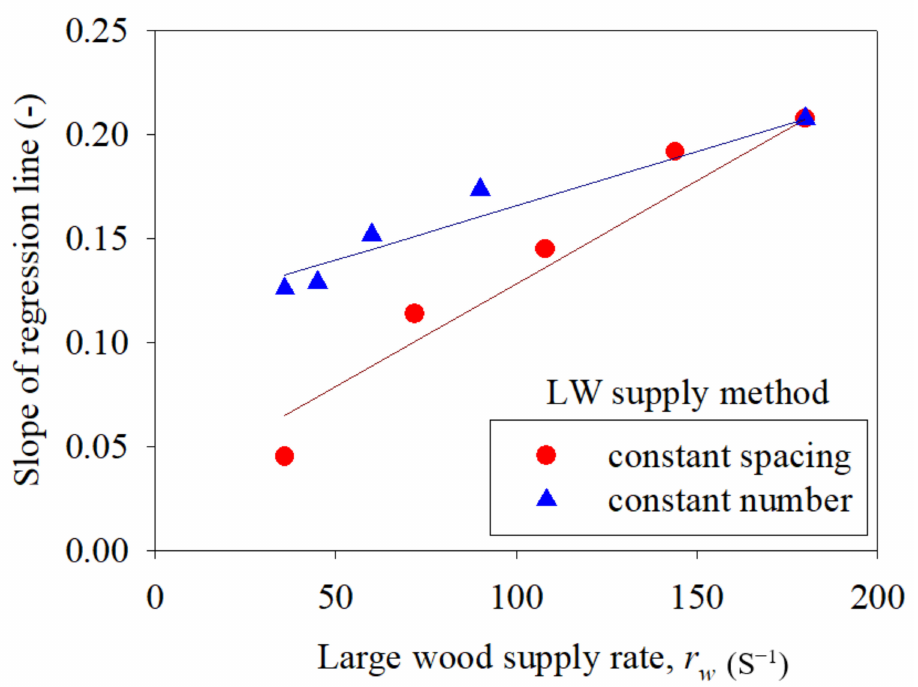
Figure 12. Comparison of dependency of the slope of regression line on LW supply rate between two different LW supply methods (i.e., constant-spacing and constant-number). The red and blue lines indicate regression lines for constant-spacing and constant-number LW supply methods,